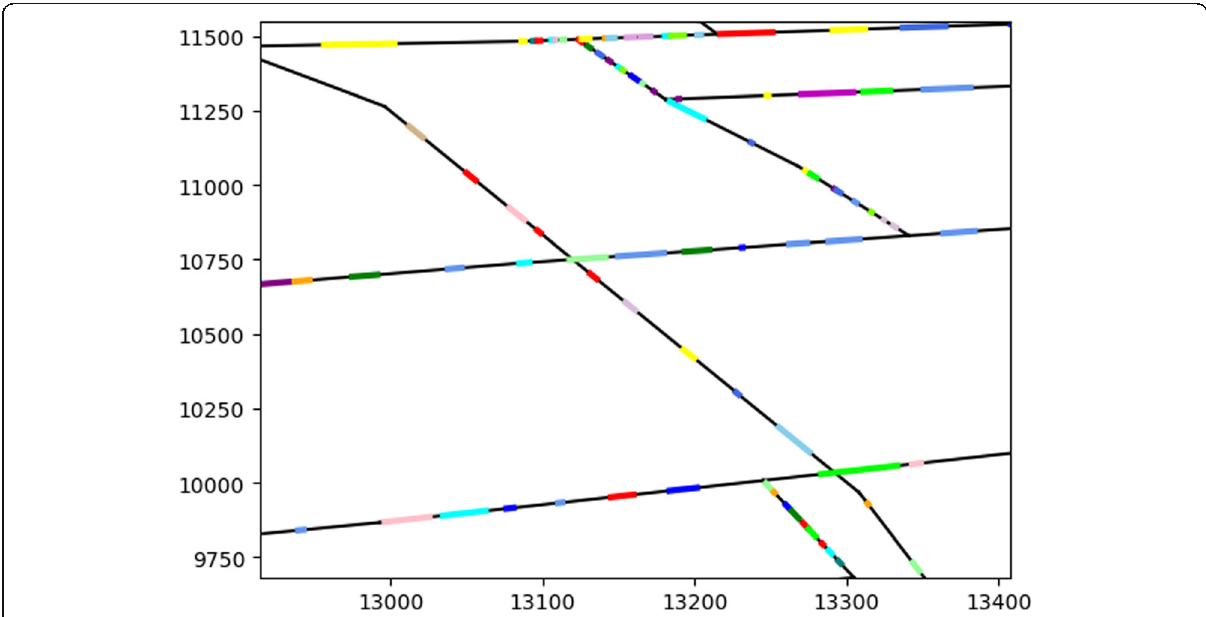
Fig. 9 Location semantics information distribution on the part of roads with semantics information. As shown in this figure, the generator generates 10 different location semantics, which randomly are distributed in the original road